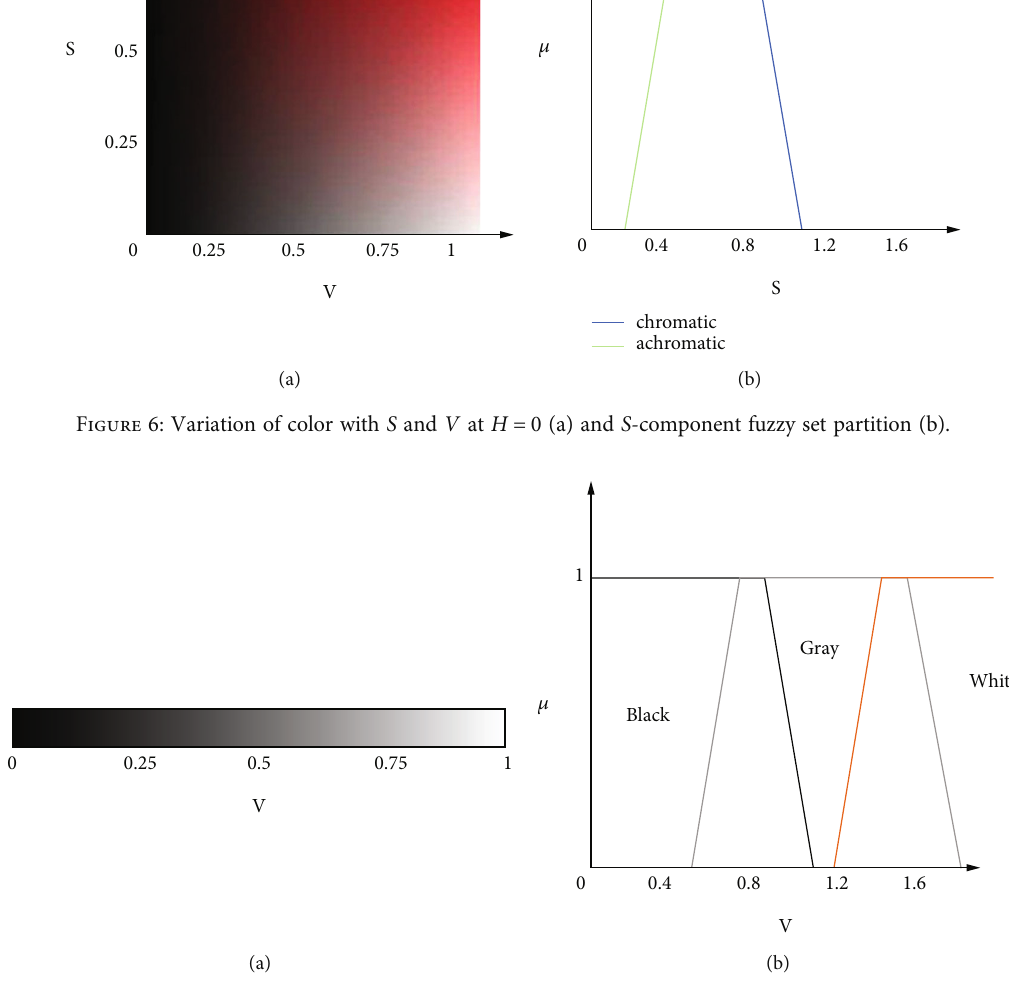
Figure 7: Plot of ceramic material color as a function of V (a) and V -component fuzzy set partition (b).